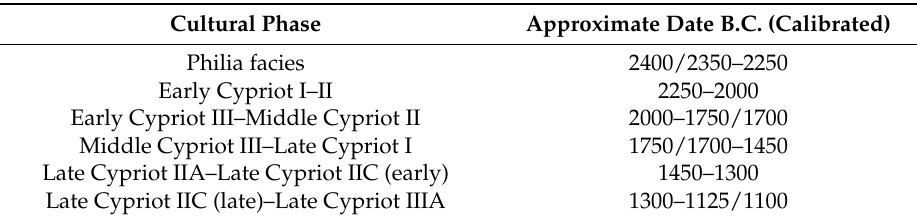
Table 1. Chronological table for Bronze Age Cyprus (after Knapp 2013, Table